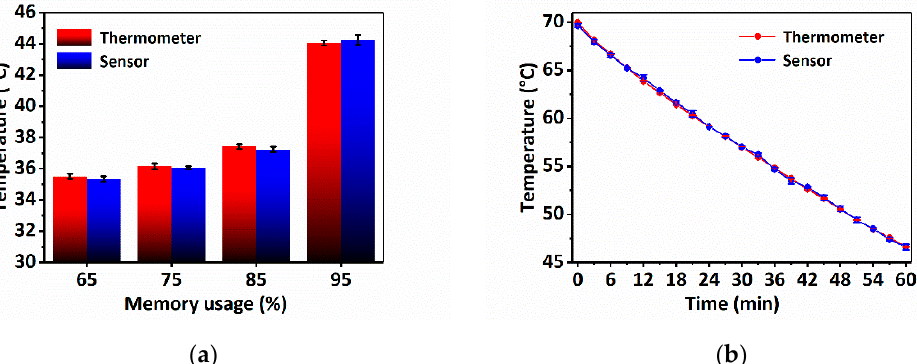
Figure 7. Sensor practical applications. ( a ) Laptop temperature detection; ( b ) hot water-cooling temperature detection.